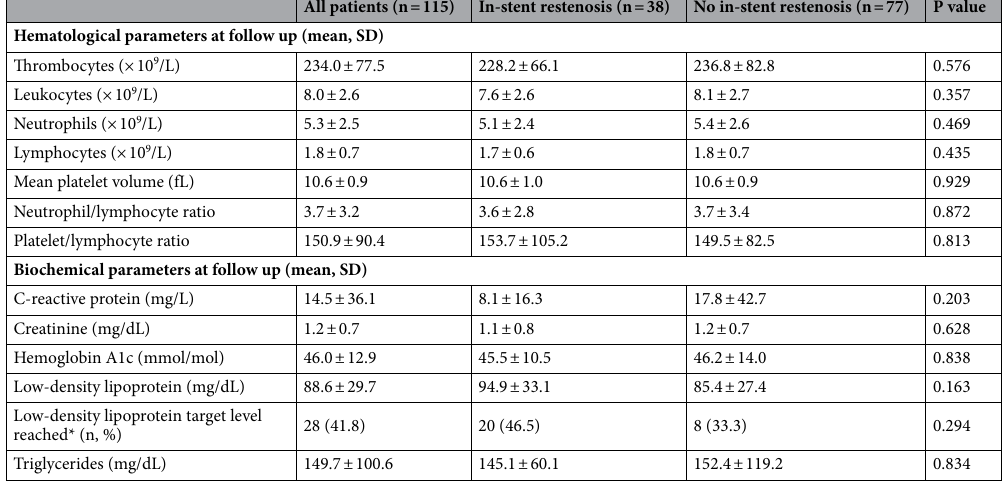
Table 2. Laboratory parameters at last follow-up dichotomized according to the occurrence of in-stent restenosis after stenting of symptomatic intracranial artery stenosis. *Target levels were set according to recent guideline recommendations (2005–2010: LDL < 100 mg/dL; since 2011: LDL < 70